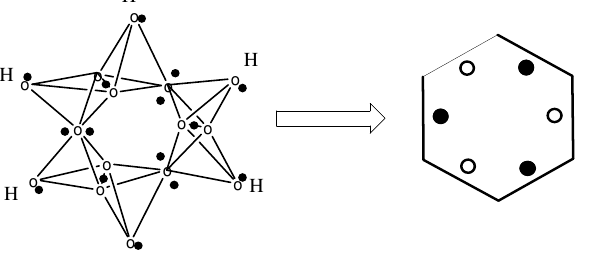
Figure 12. Linnett's representation of benzene molecule with three-electron